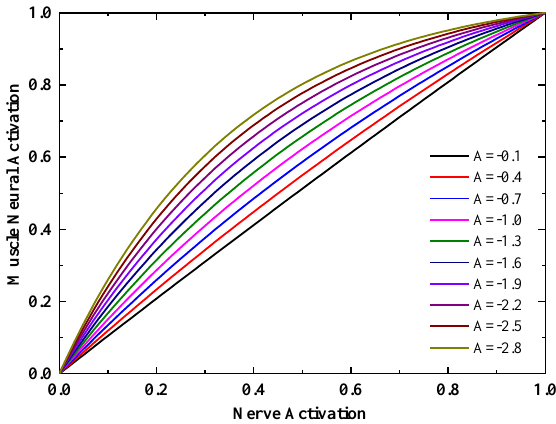
Figure 3. Effect of A on muscle neural activation.